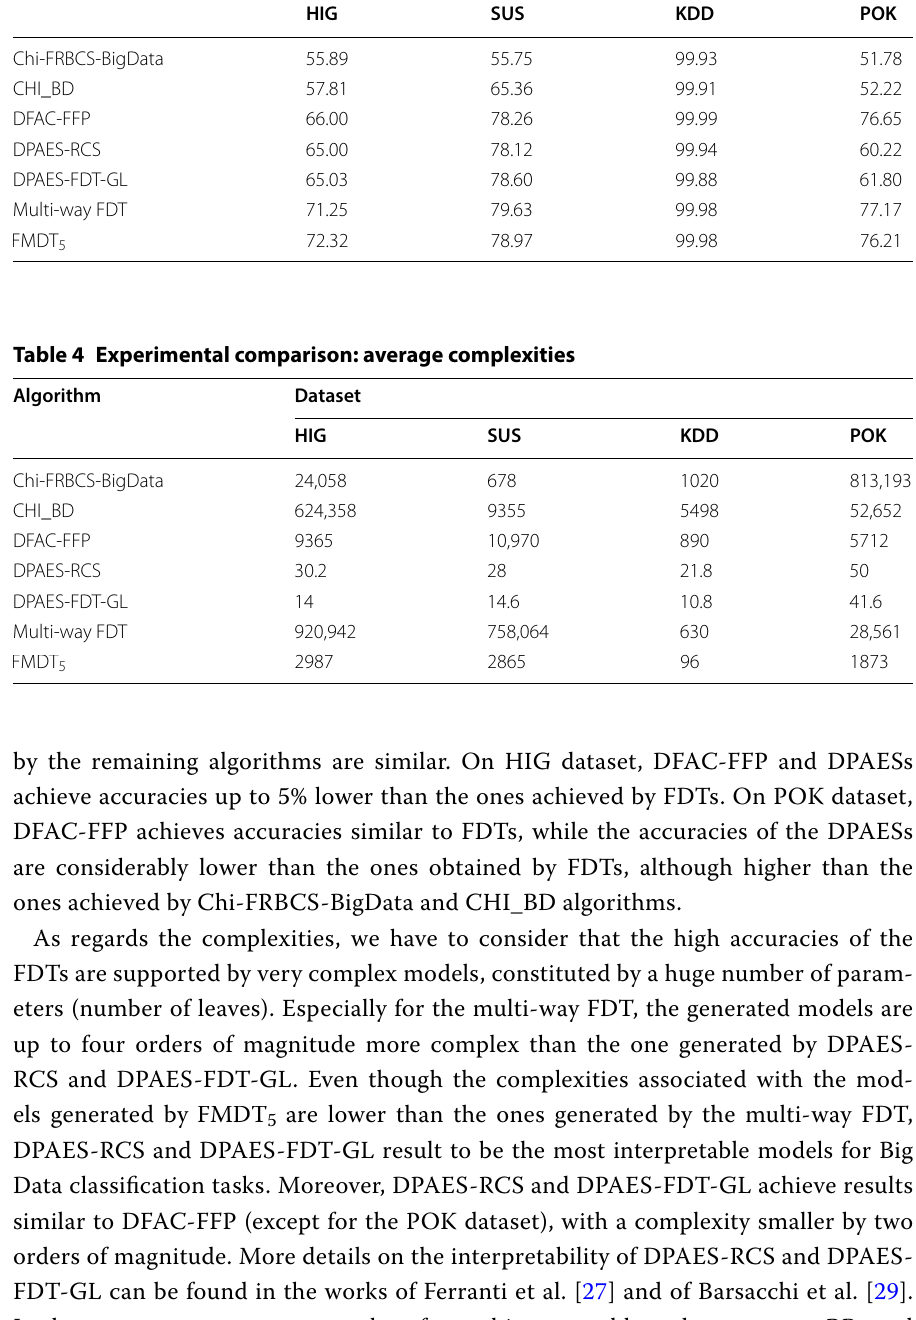
Table 3 Experimental comparison: average accuracies on the test set Algorithm